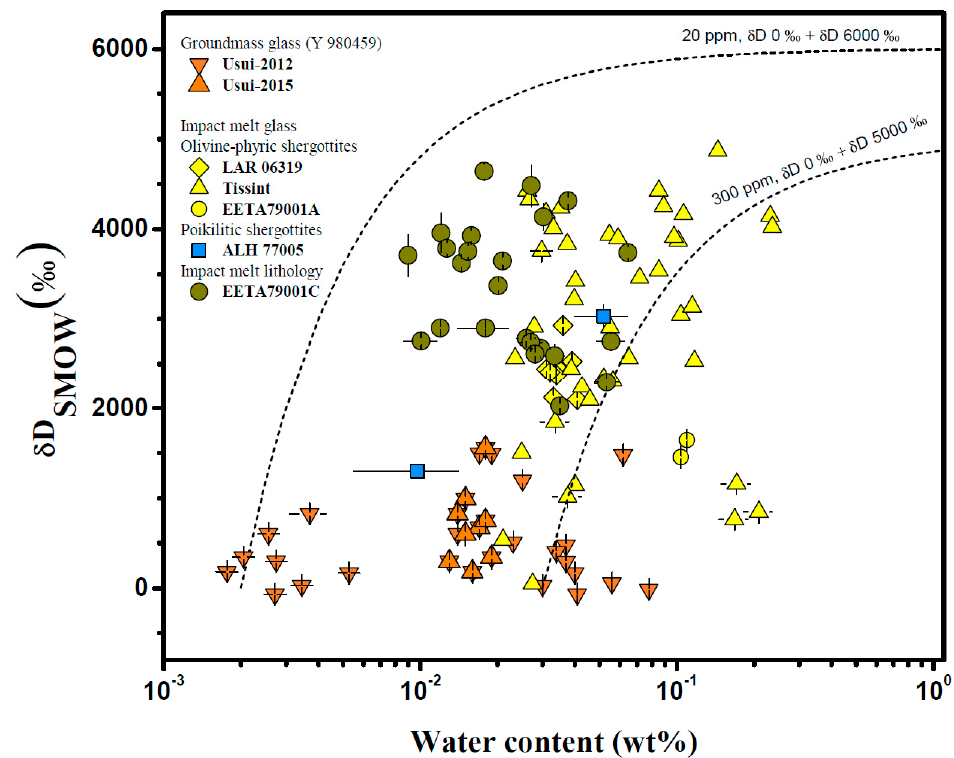
Figure 5. The relationship between water content and δ D values of groundmass glasses and impact melt glasses from Martian shergottites. Most datasets are plotting along a two end-member mixing trend except for some spots shifting towards to higher water content. Groundmass glasses of Y 980459 from [53,72] . Impact melt glasses: LAR 06319 (LAR06) and EETA 79001A (EETA-A) from [72] , Tissint from [60,65,70] , EETA 79001C from [71] , ALH 77005 (ALH) from [59] . Groundmass glasses from olivine-phyric shergottites, such as Y-980459, probably quenched from the parent melt [127]. They have 18–800 ppm water content and δ D values of − 71–1562 ‰ (assuming H 2 O = H/Si without absolute concentration calibration) [53,72]. The water content (100– 200 ppm) of the groundmass glasses in Y 980459 positively correlate with δ D values (181–1562 ‰)